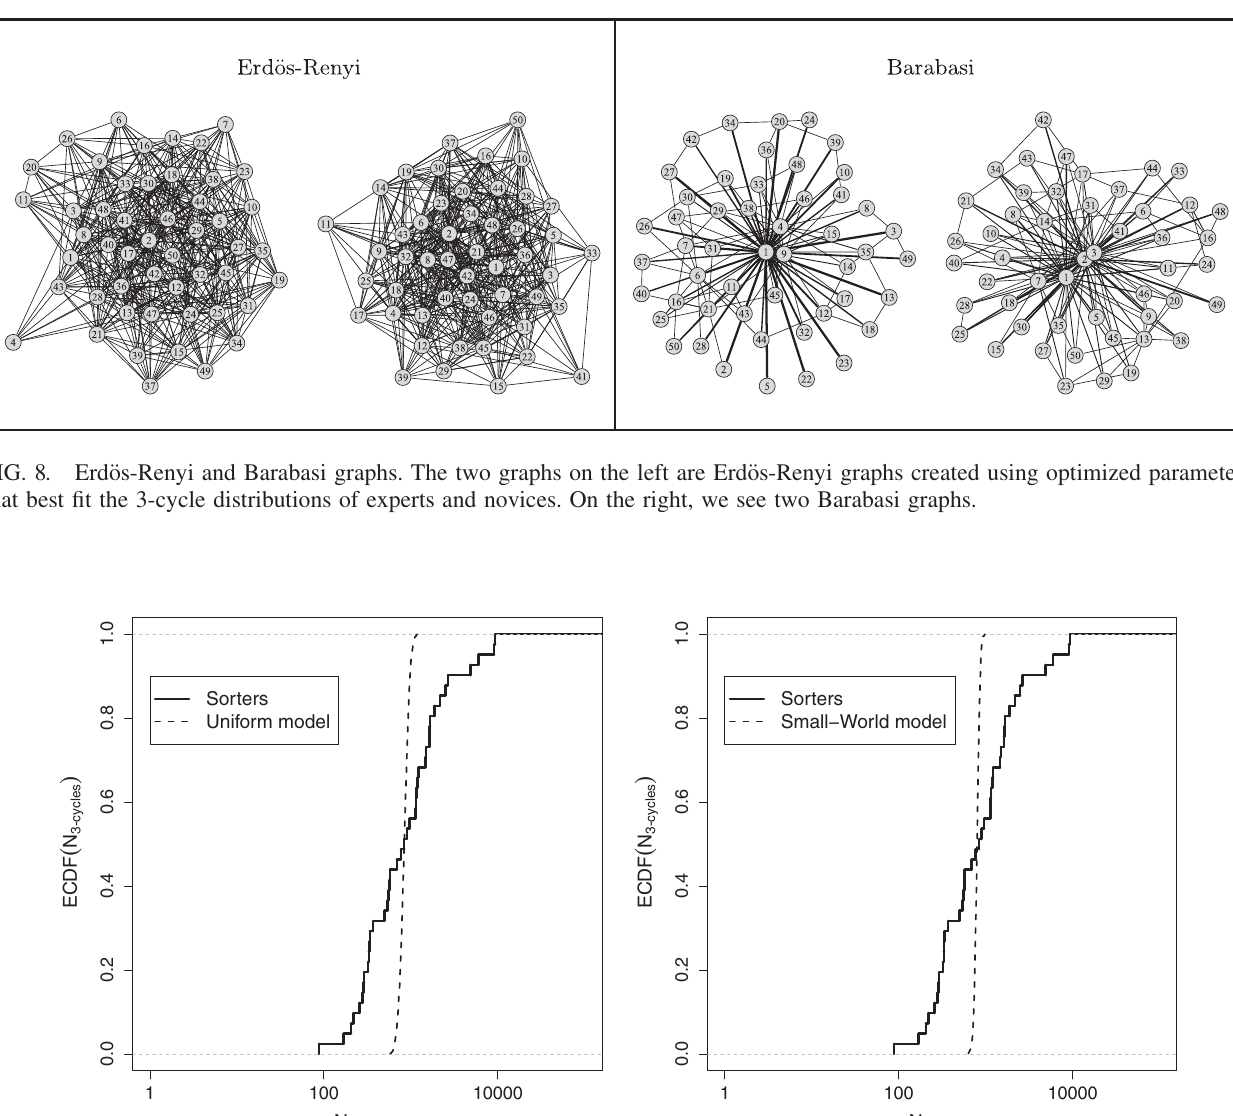
EMPIRICAL APPROACH TO INTERPRETING . .